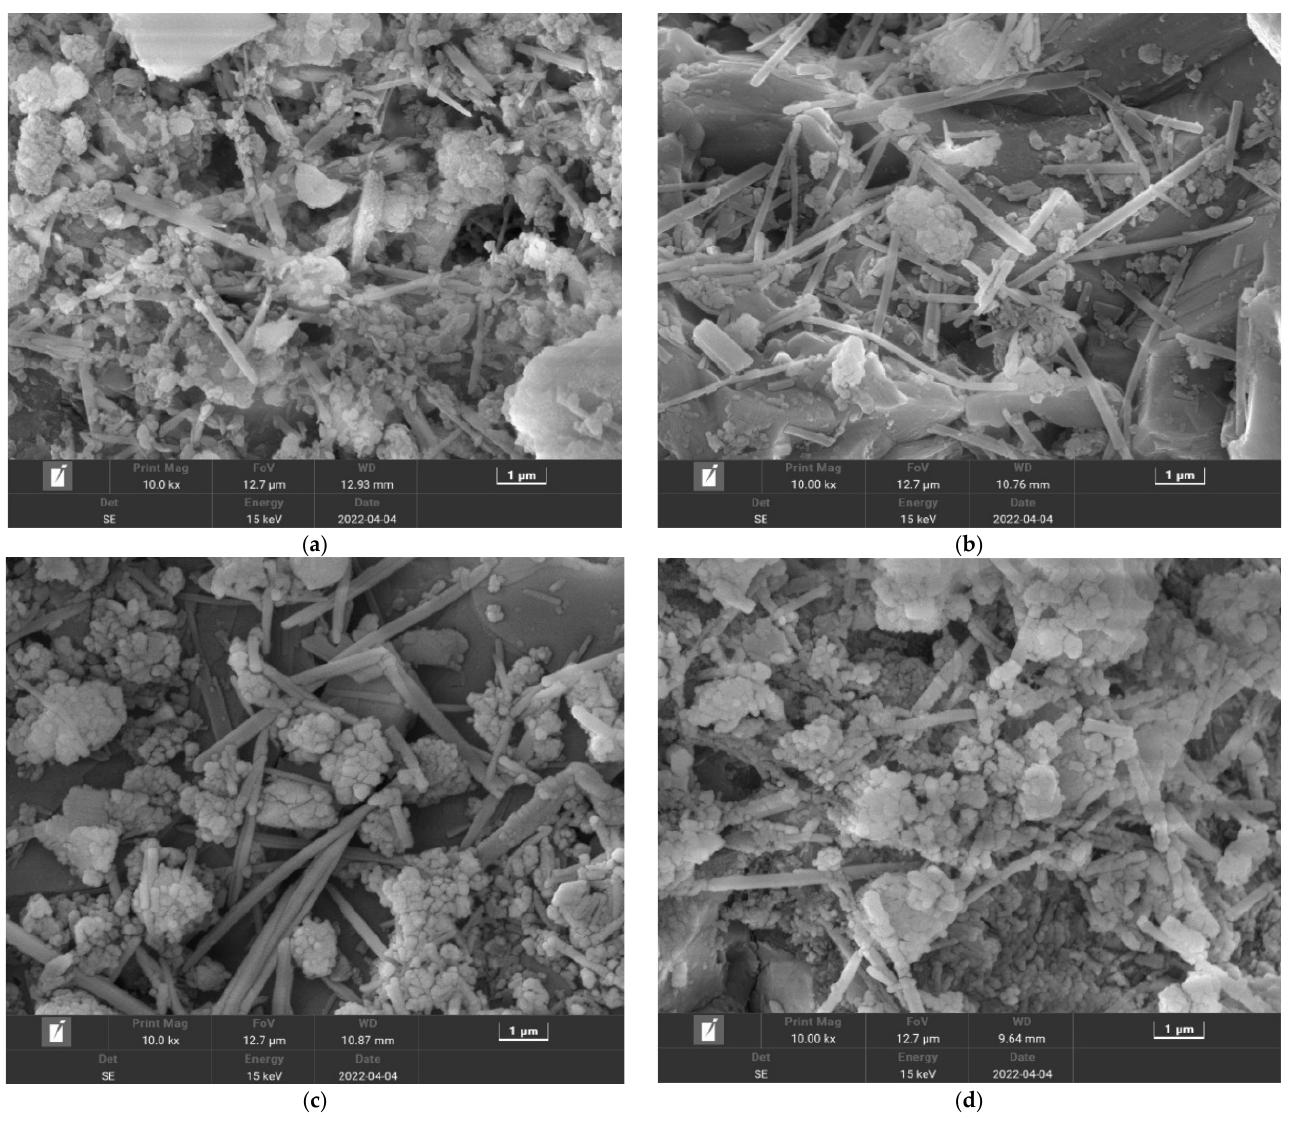
Figure 10. Microstructure of cement mortar with NC: ( a ) 1% NC; ( b ) 2% NC; ( c ) 4% NC; ( d ) 8% NC.